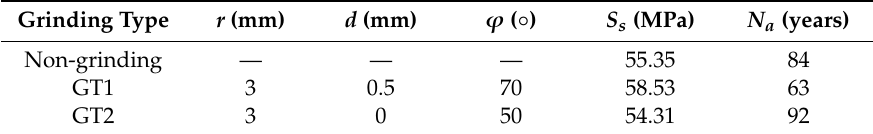
Figure 23. Finite element models of different grinding radii. According to the fatigue life calculation steps in Section 5.4, the variation of the fatigue life with the grinding radius for GT2 under different weld types is shown in Figure 24. In this figure: